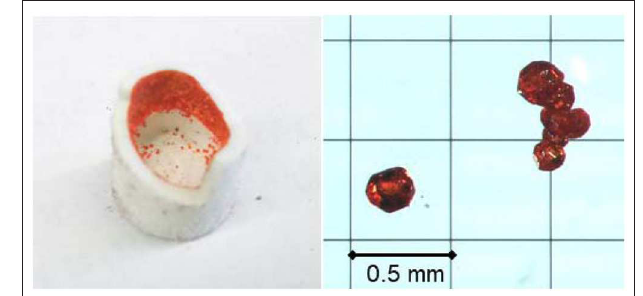
FIGURE 2 | Photographs of single crystals of Ce 2 CaMg 2 Ge 3 O 12 grown on the inner wall of a MgO crucible. (Malysa et al., 2018), RE 3 Ga 5 O 12 ( RE = Pr–Eu) (Sawada, 1997; Sawada et al., 2016), Li 7 La 3 Zr 2 O 12 (Awaka et al., 2009),